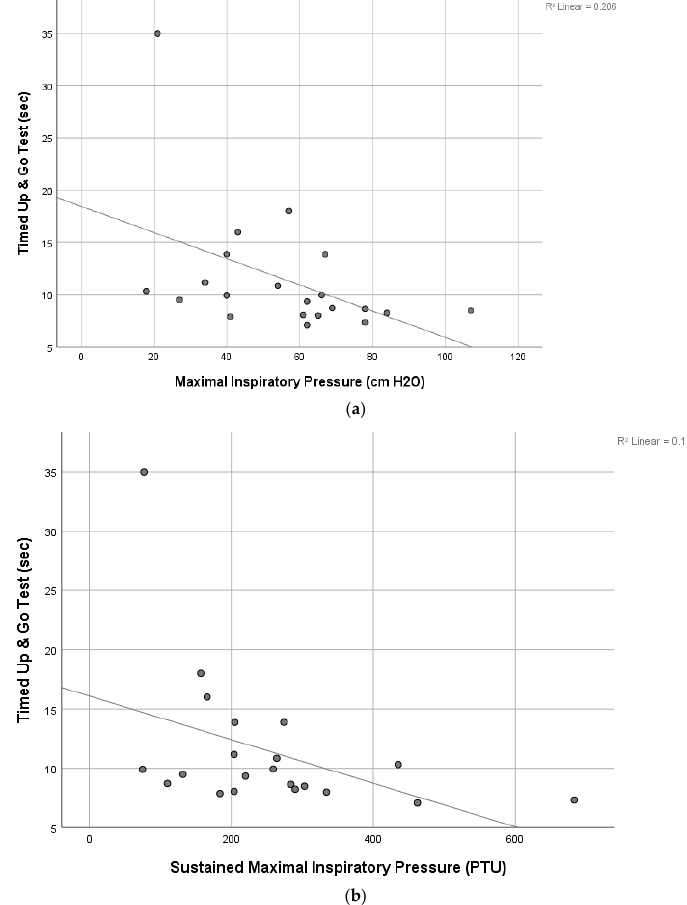
Figure 3. ( a ). Scatterplot of the relationship between maximal inspiratory pressure and the timed up and go test. ( b ). Scatterplot of the relationship between sustained maximal inspiratory pressure and the timed up and go test. J. Cardiovasc. Dev. Dis. 2023 , 10 , x FOR PEER REVIEW